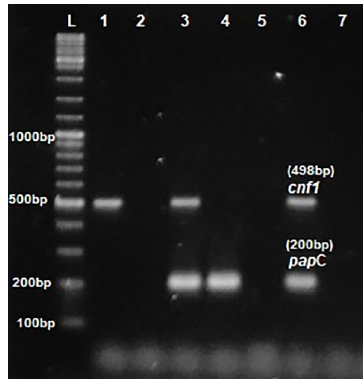
Figure 1. Multiplex PCR for pap C & cnf 1. L- ladder 1000+ bp, lane 1-6: test isolates, lane 7: Negative control.